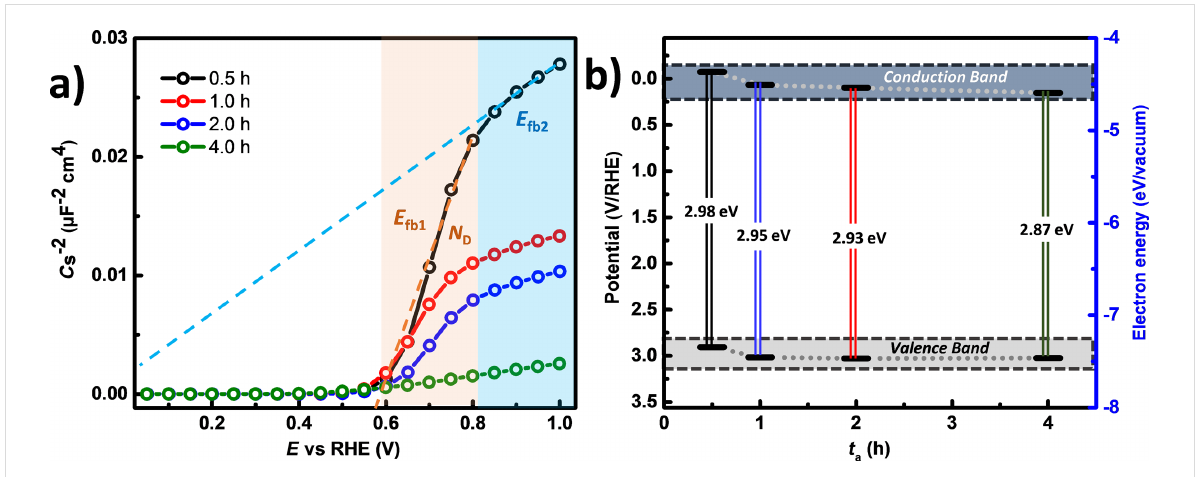
Figure 8: a) Mott–Schottky plots recorded at f = 400 Hz in 0.5 M H 2 SO 4 . The electrode potential range was from − 0.2 to 1.0 V vs SCE with a poten- tial step of 50 mV and 2 min of stabilization time. Table 3 shows the dopant number concentration ( N D ) calculated by using Equation 2. b) Schematic for the band diagram estimated from the